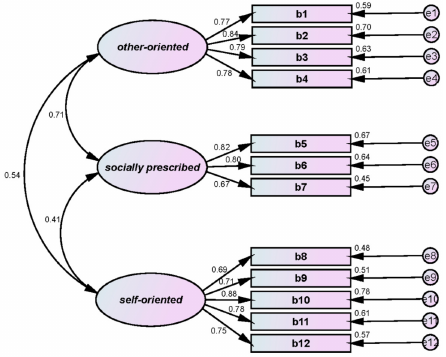
Figure 2. Perfectionism